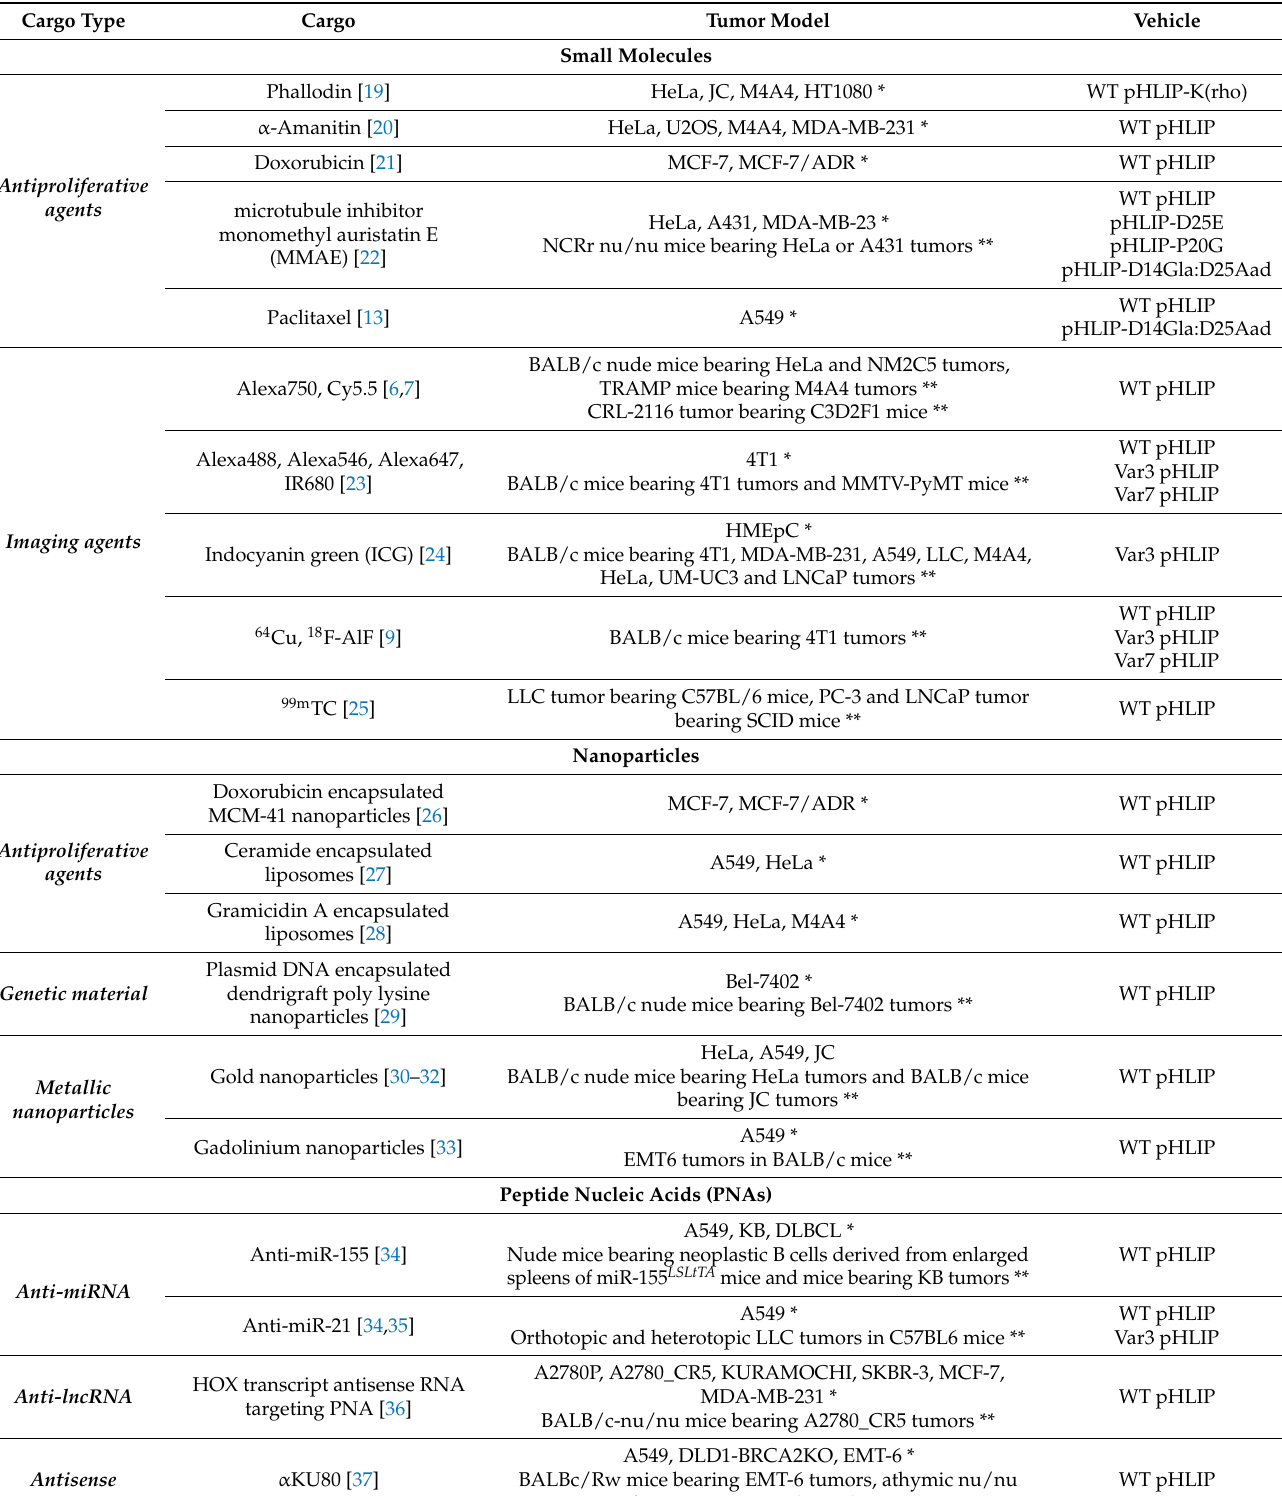
Table 1. Selected cargo types delivered by pH-low insertion peptides